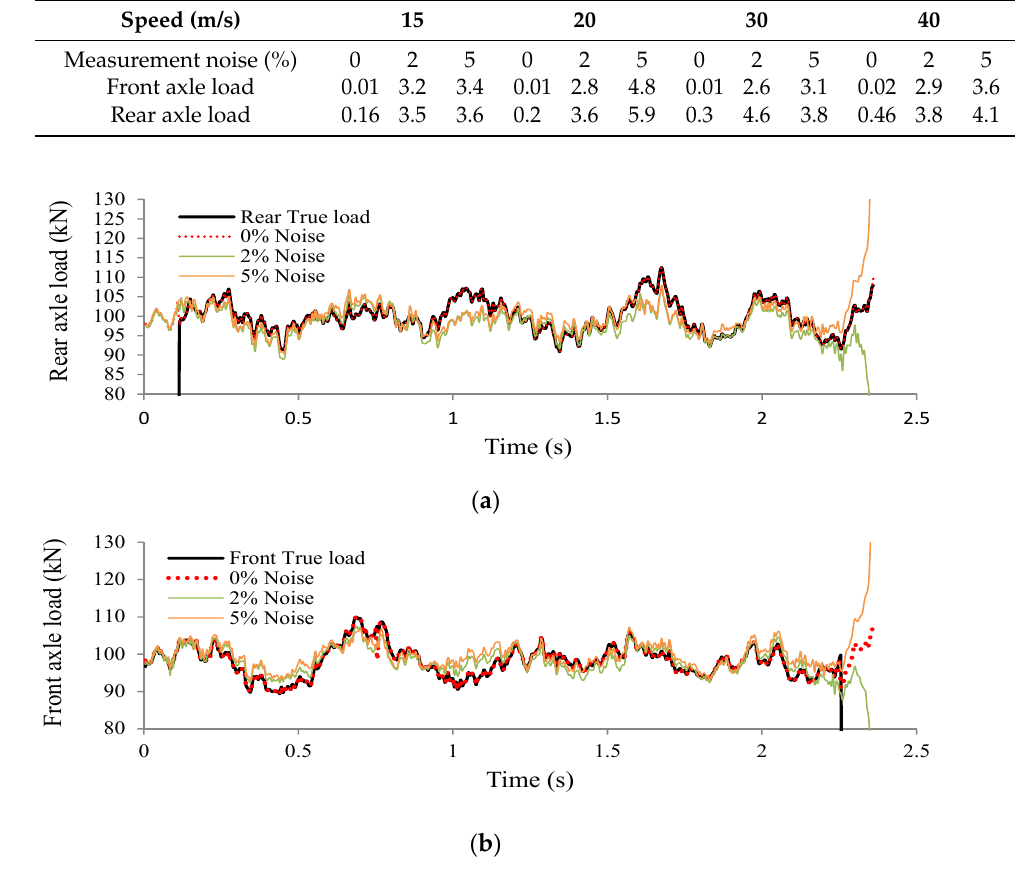
Figure 8. Effect of noise on load identification at road roughness level A and speed of 40 m/s: ( a ) rear axle load identification, ( b ) front axle load identification.